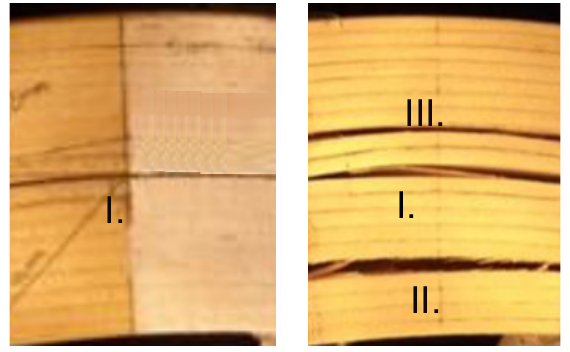
Figure 6. Arch crown cracking (primary I., secondary II. and tertiary III.) during experiment at two load